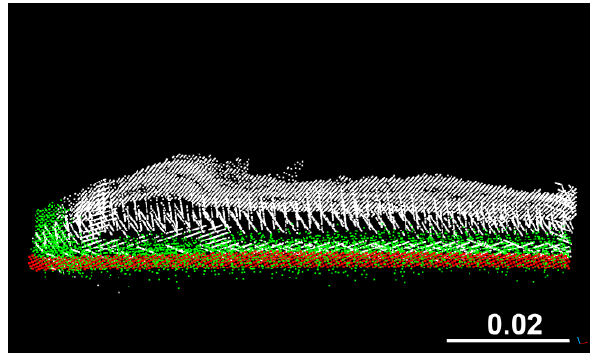
Figure 9 . Slice of the point clouds in A-2 test area, showing different noise and shift. SfM in red, C10 in green, ZF in white.